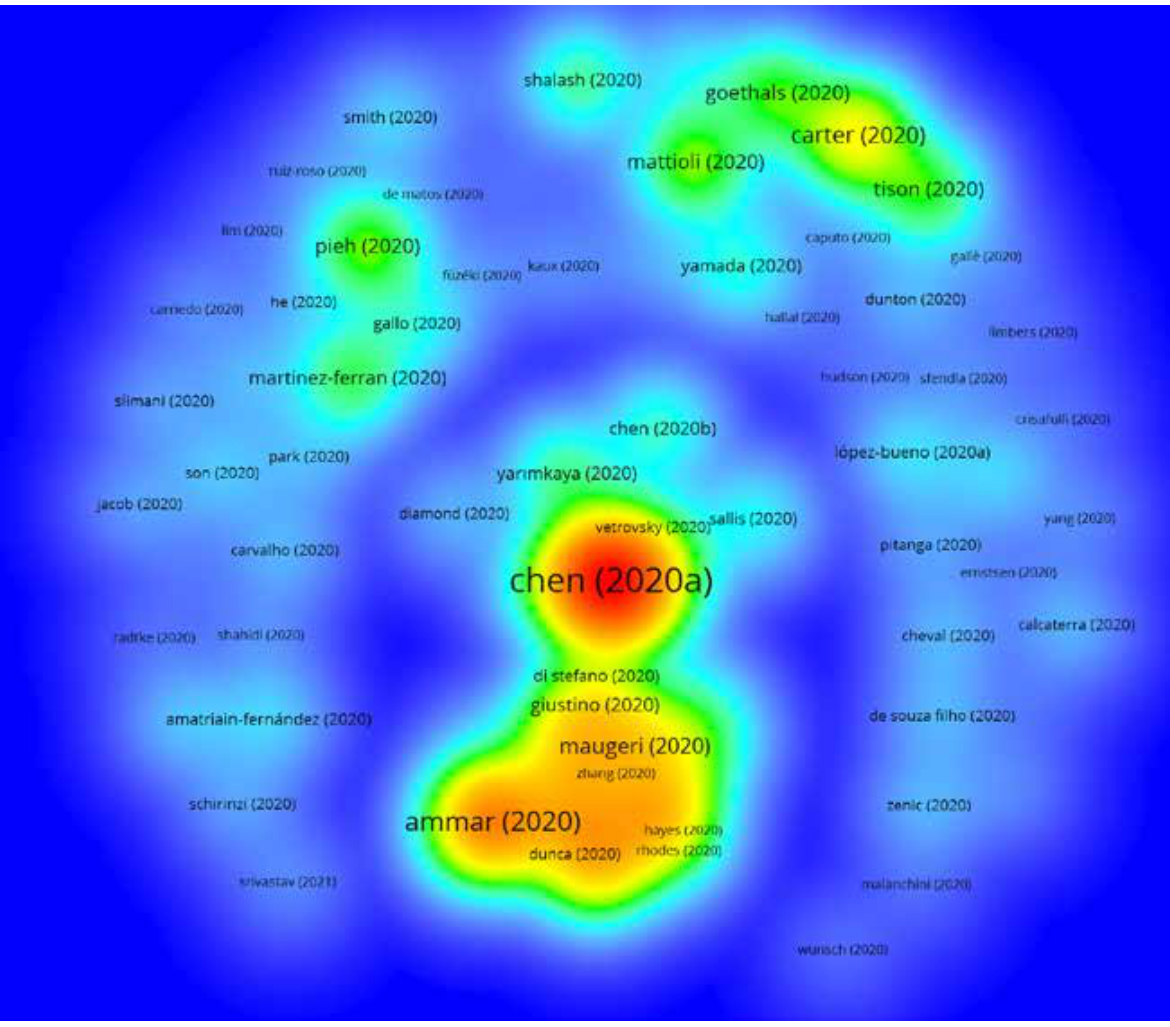
Figure 1. Core references in research on physical activity in the COVID-19 context (direct citation analysis, item density visualisation, weights – citations): Source: Own study based on data retrieved from Scopus and analysed with VOSviewer (15 January 2021). Table 3. Clusters of high-frequency keywords in research on physical activity in the COVID-19 context Cluster